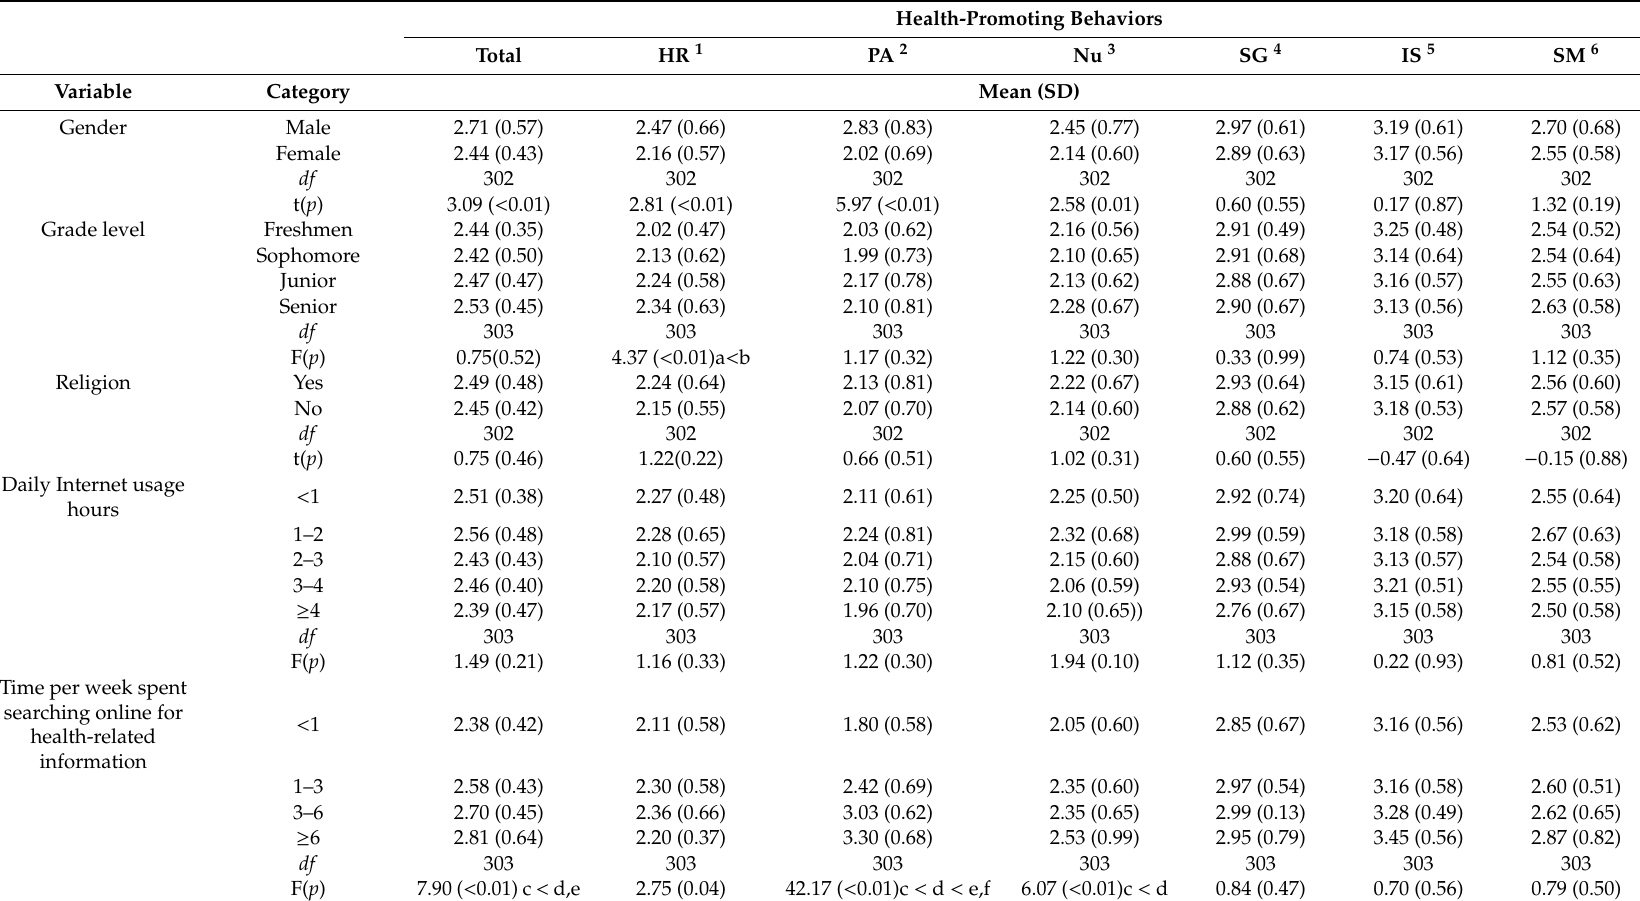
Table 2. Di ff erences in health-promoting behaviors according to general characteristics (N =